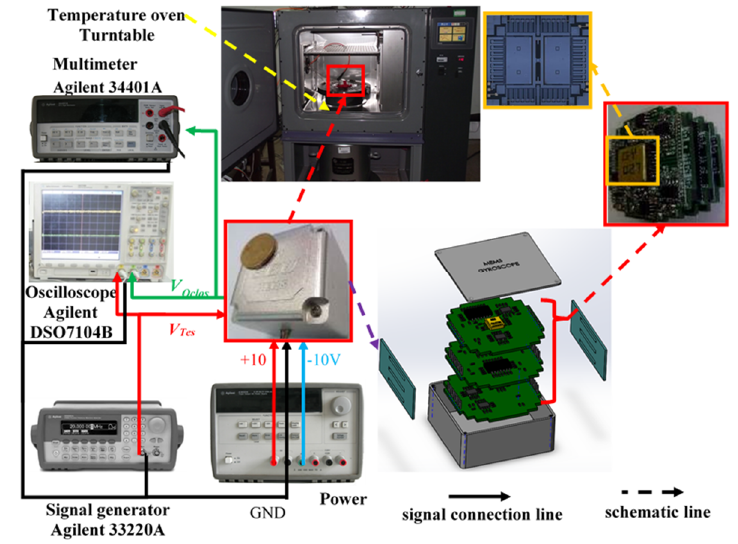
Figure 6. Experimental device.